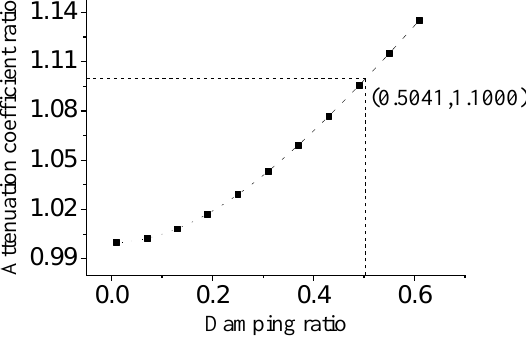
Figure 1. The change curve of attenuation coefficient ratios.